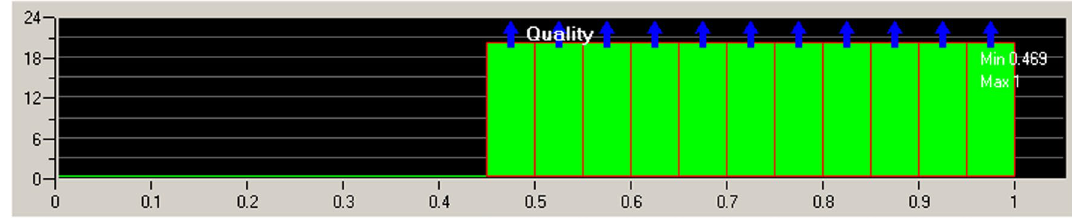
Fig. 10 Check chart of grid quality